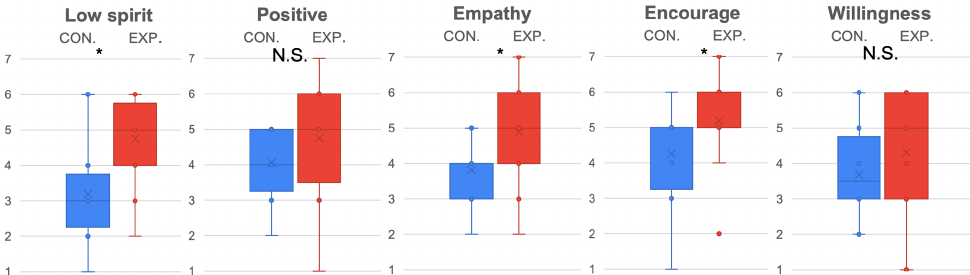
Figure 4. Emotion expression and evaluation of ERICA evaluated by all subjects. * indicates the found significant difference, while N.S. indicates there is no significant difference.